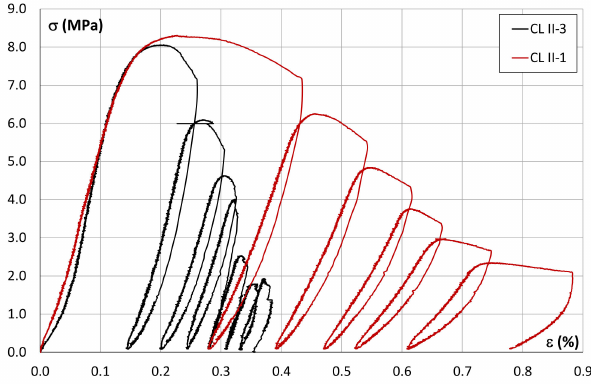
Figure 9. Stress–strain cyclic graph of the two